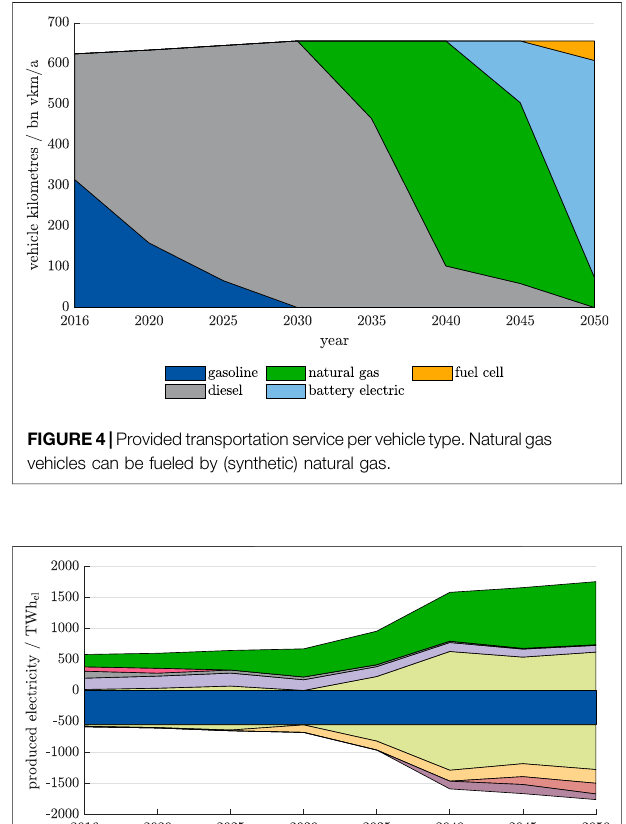
Frontiers in Energy Research |